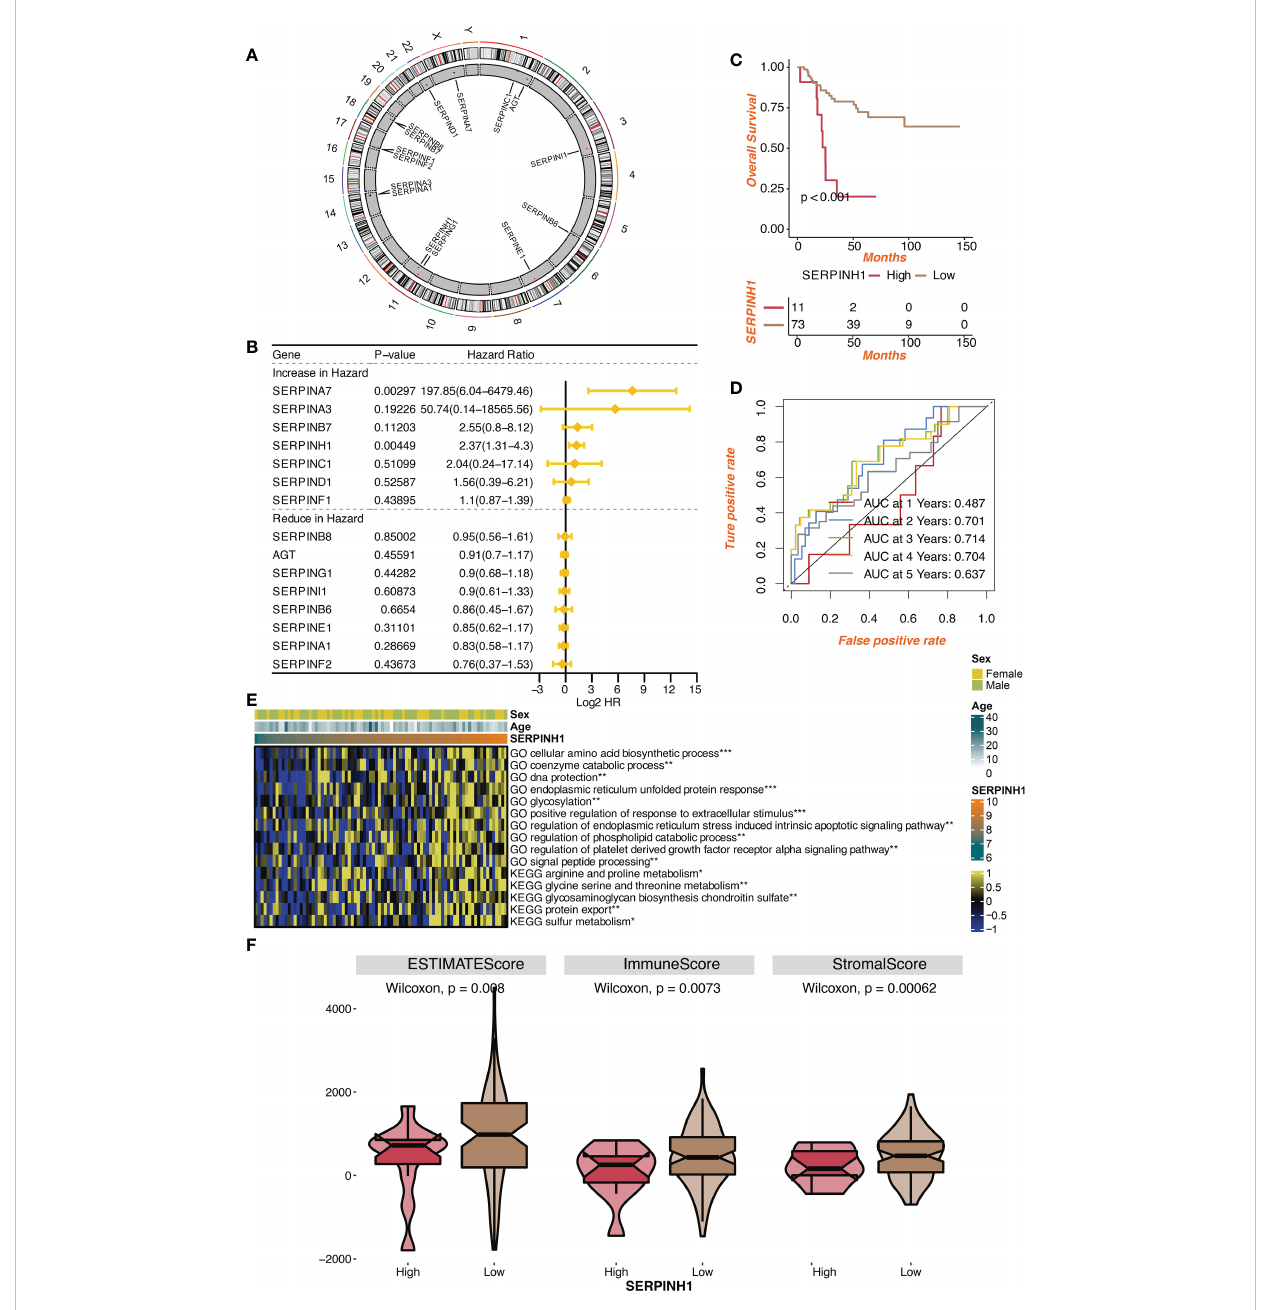
FIGURE 1 Prognostic value of serpin superfamily and SERPINH1. (A) Circplot of the serpin superfamily in human chromosomes. (B) Univariate Cox regression analysis on the serpin superfamily. (C) Survival curves of the two SERPINH1-strati fi ed groups. (D) The 1-year, 2-year, 3-year, 4-year, and 5-year ROC regarding SERPINH1. (E) The correlation between SERPINH1 and GO, KEGG terms quanti fi ed by GSVA. (F) The levels of microenvironment scores in two SERPINH1 groups. *P<0.05; **P<0.01;